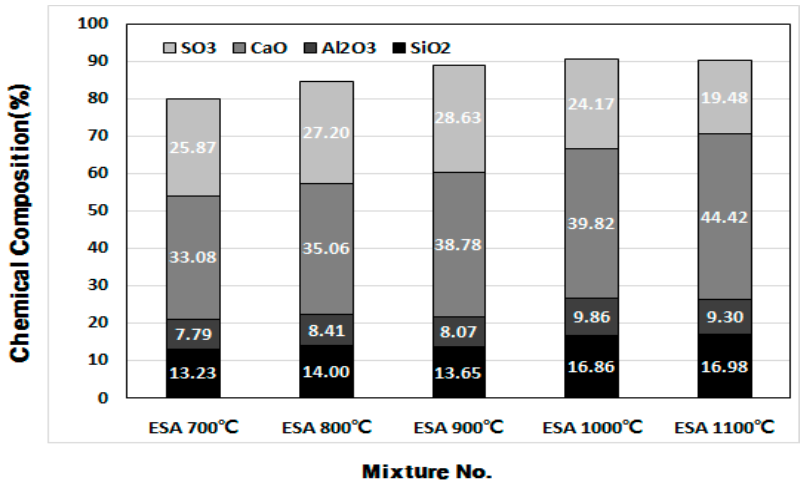
Figure 9. Change in ESA chemical composition (%) at different burning temperatures.